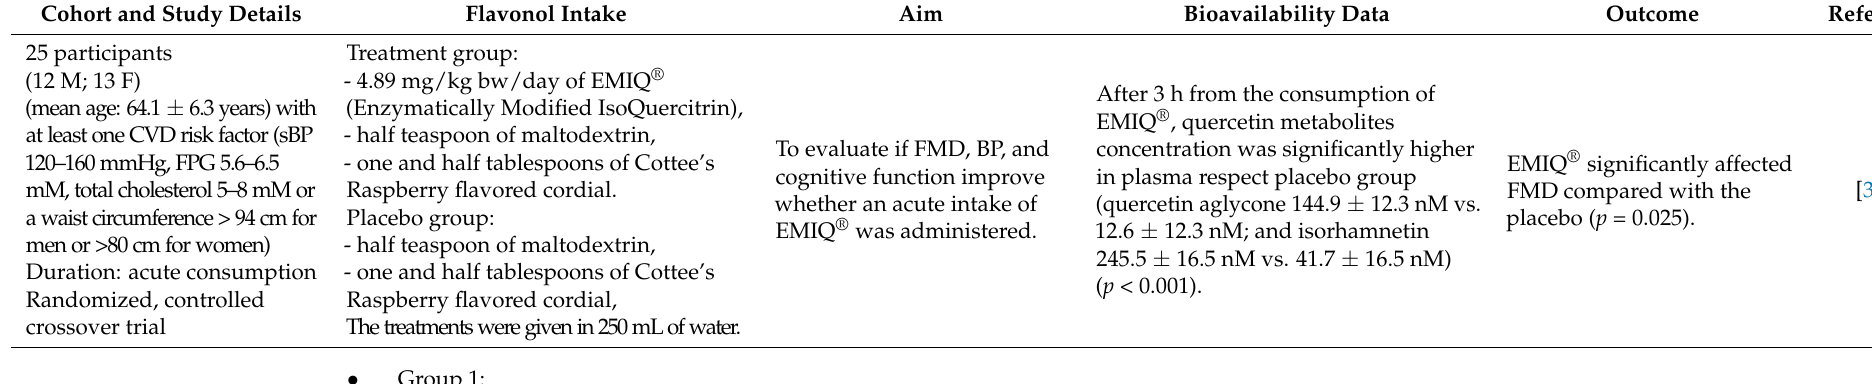
Table 3. Flavonols’ beneficial effects and bioavailability in human